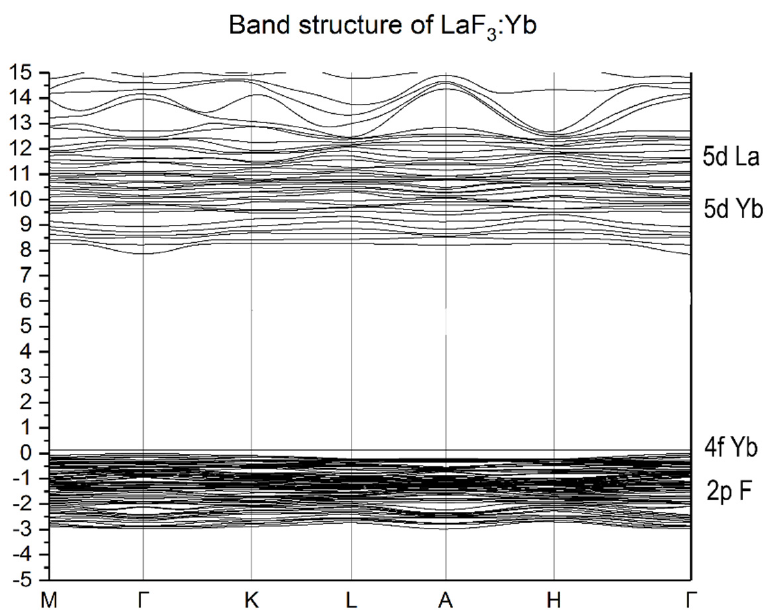
Figure 3. The energy band structure of LaF 3 :Yb.